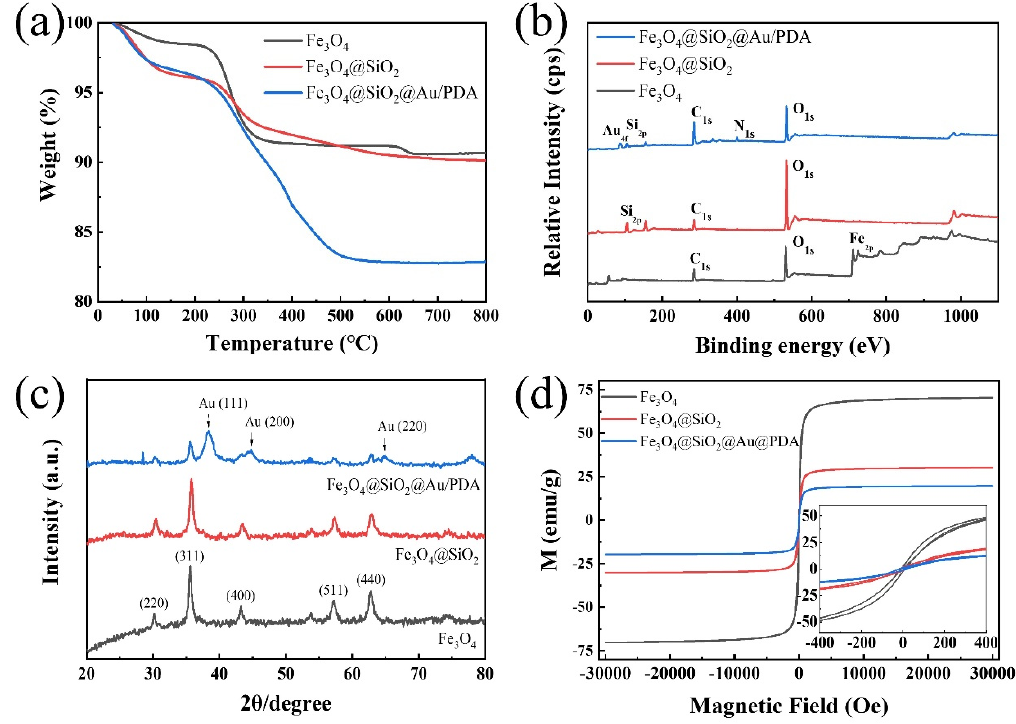
Figure 6. TG curves ( a ), XPS spectra ( b ), XRD diffraction patterns ( c ), and room temperature (300 K) magnetization hysteresis loops ( d ) of Fe 3 O 4 , Fe 3 O 4 @SiO 2 , and Fe 3 O 4 @SiO 2 @Au/PDA nanochains. The inset of d is the enlarged loops of the nanochains.